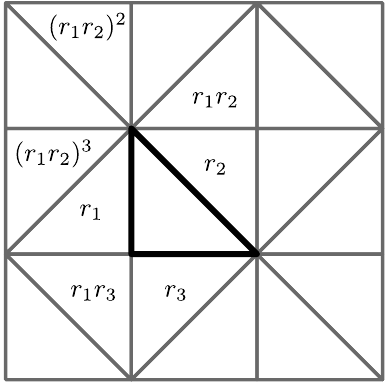
FIG. 13. An illustration of the Coxeter kaleidoscope. The ver- tices of the Coxeter diagram 44 correspond to three reflecting hyperplanes r 1 , r 2 , and r 3 (labeled left to right). In the figure, the reflecting hyperplanes are the sides of the black triangle (the fun- damental region). As specified by the diagram, r 1 and r 3 have dihedral angle π/ 2, whereas r 1 and r 2 have dihedral angle π/ 4 (as do r 2 and r 3 ). We show a subset of the (infinite) reflections of the fundamental region and we label some of these reflections in terms of r 1 , r 2 , and r 3 . From the figure, we see that ( r 1 r 3 ) 2 = 1 and ( r 1 r 2 ) 4 = 1, matching the Coxeter